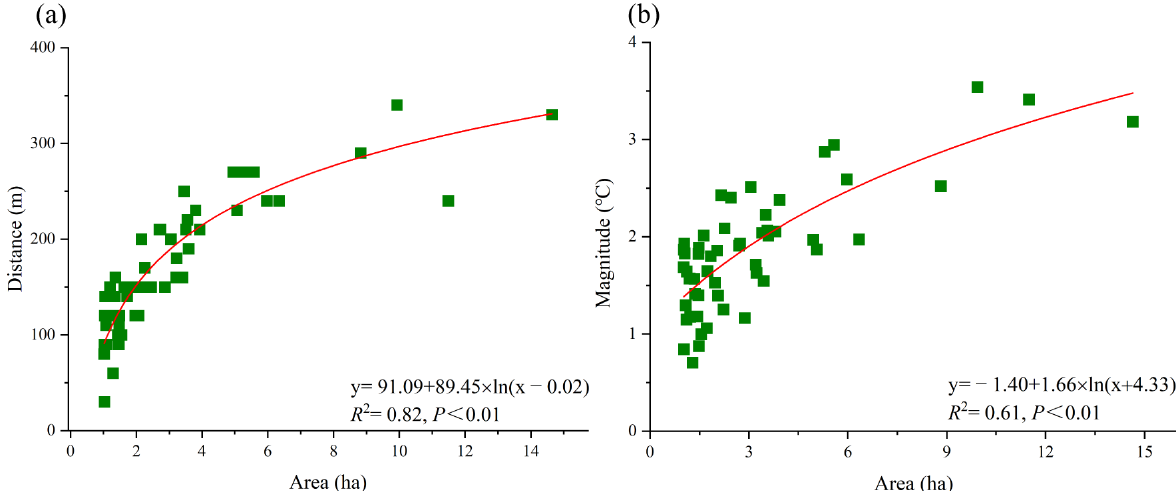
Figure 3. Relationship between the green space area and cooling distance/magnitude. ( a ) area VS cooling distance; ( b ) area VS cooling magnitude.